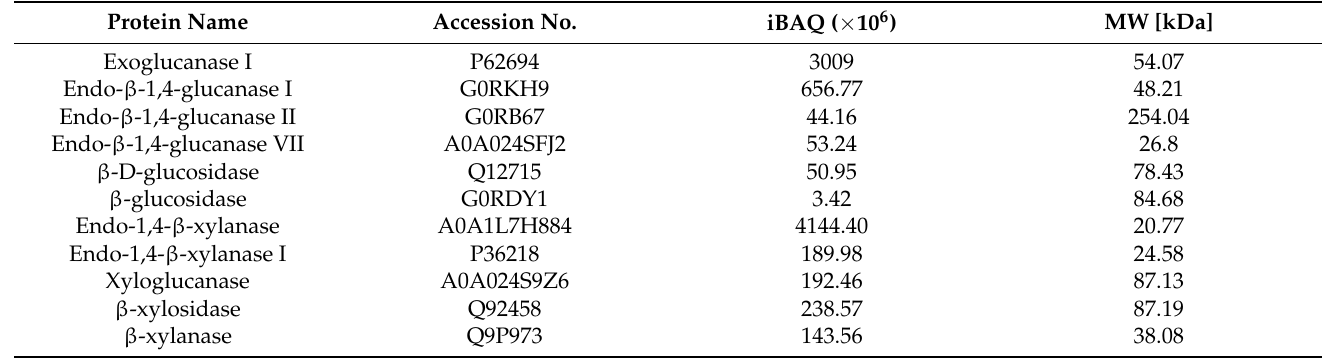
Table 3. The LC–MS/MS assay of T. reesei -secreted enzymes incubated with corn stalk and 0.05% FeCl 3